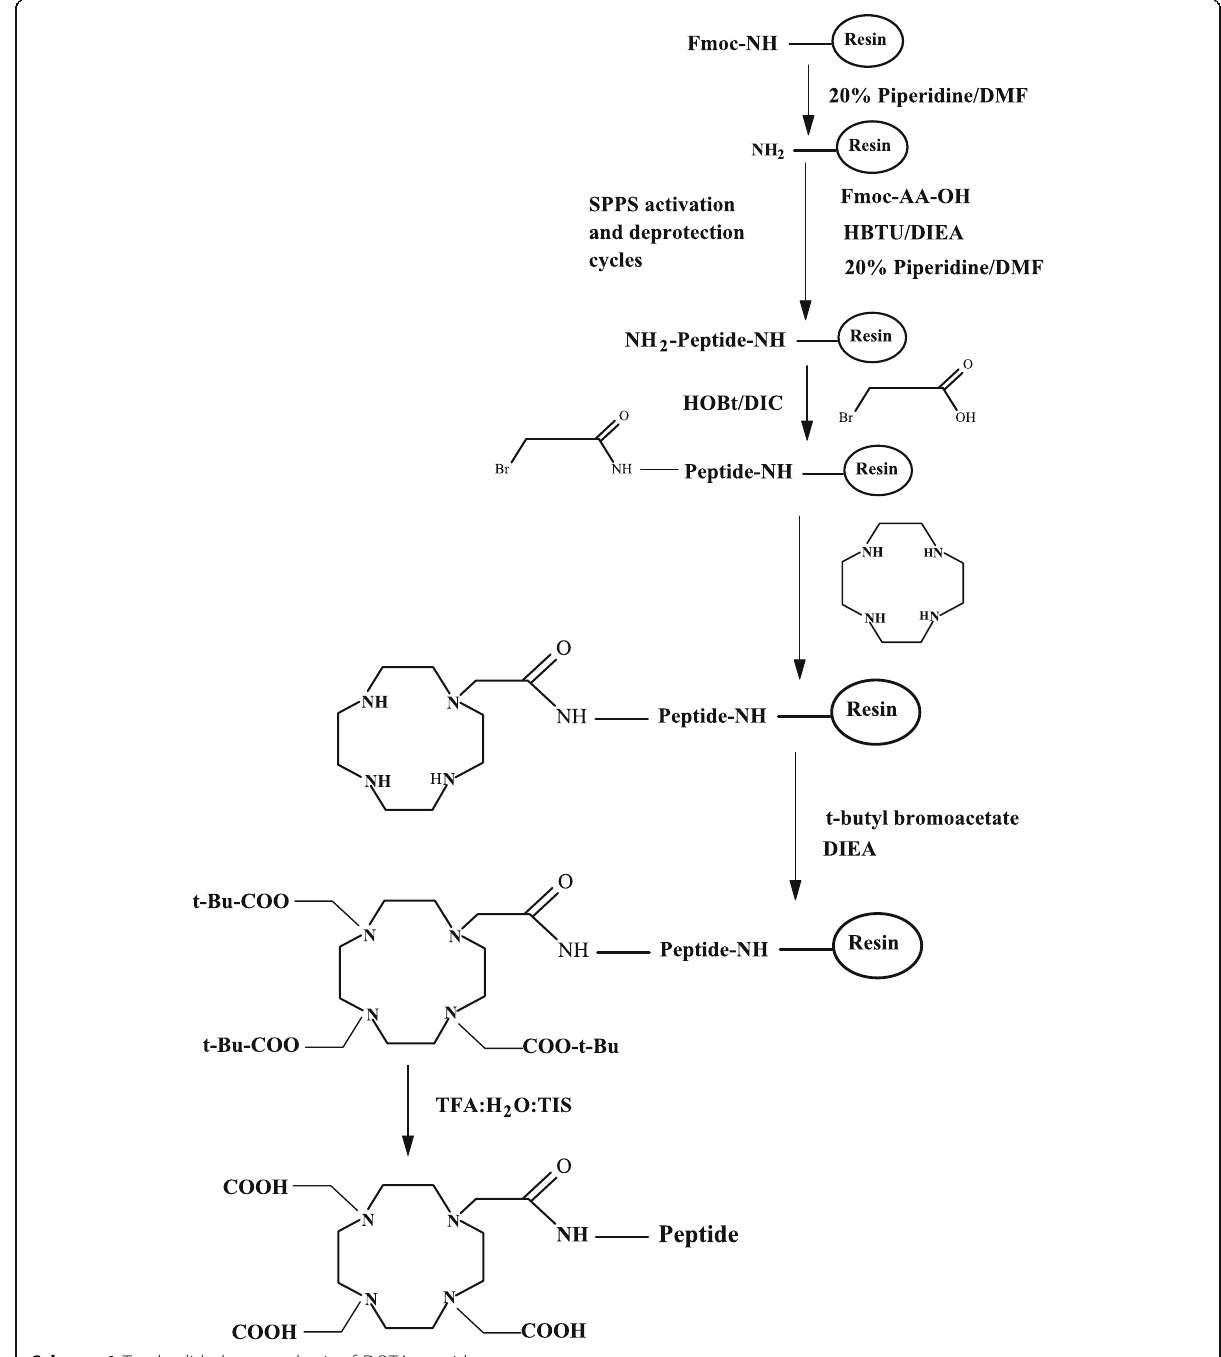
Scheme 1 Total solid-phase synthesis of